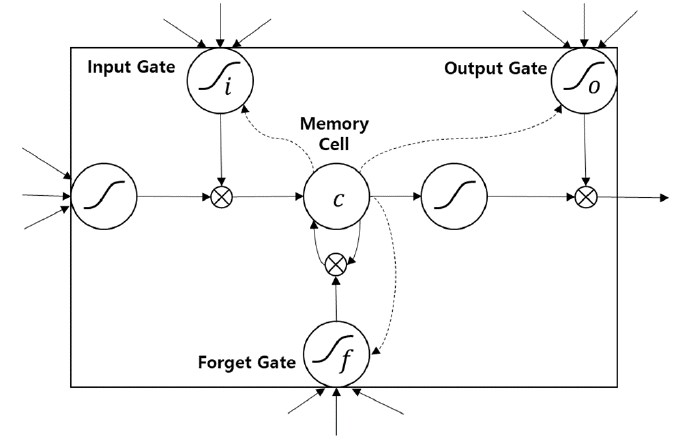
Figure 2. Long Short-Term Memory block modified from [26].